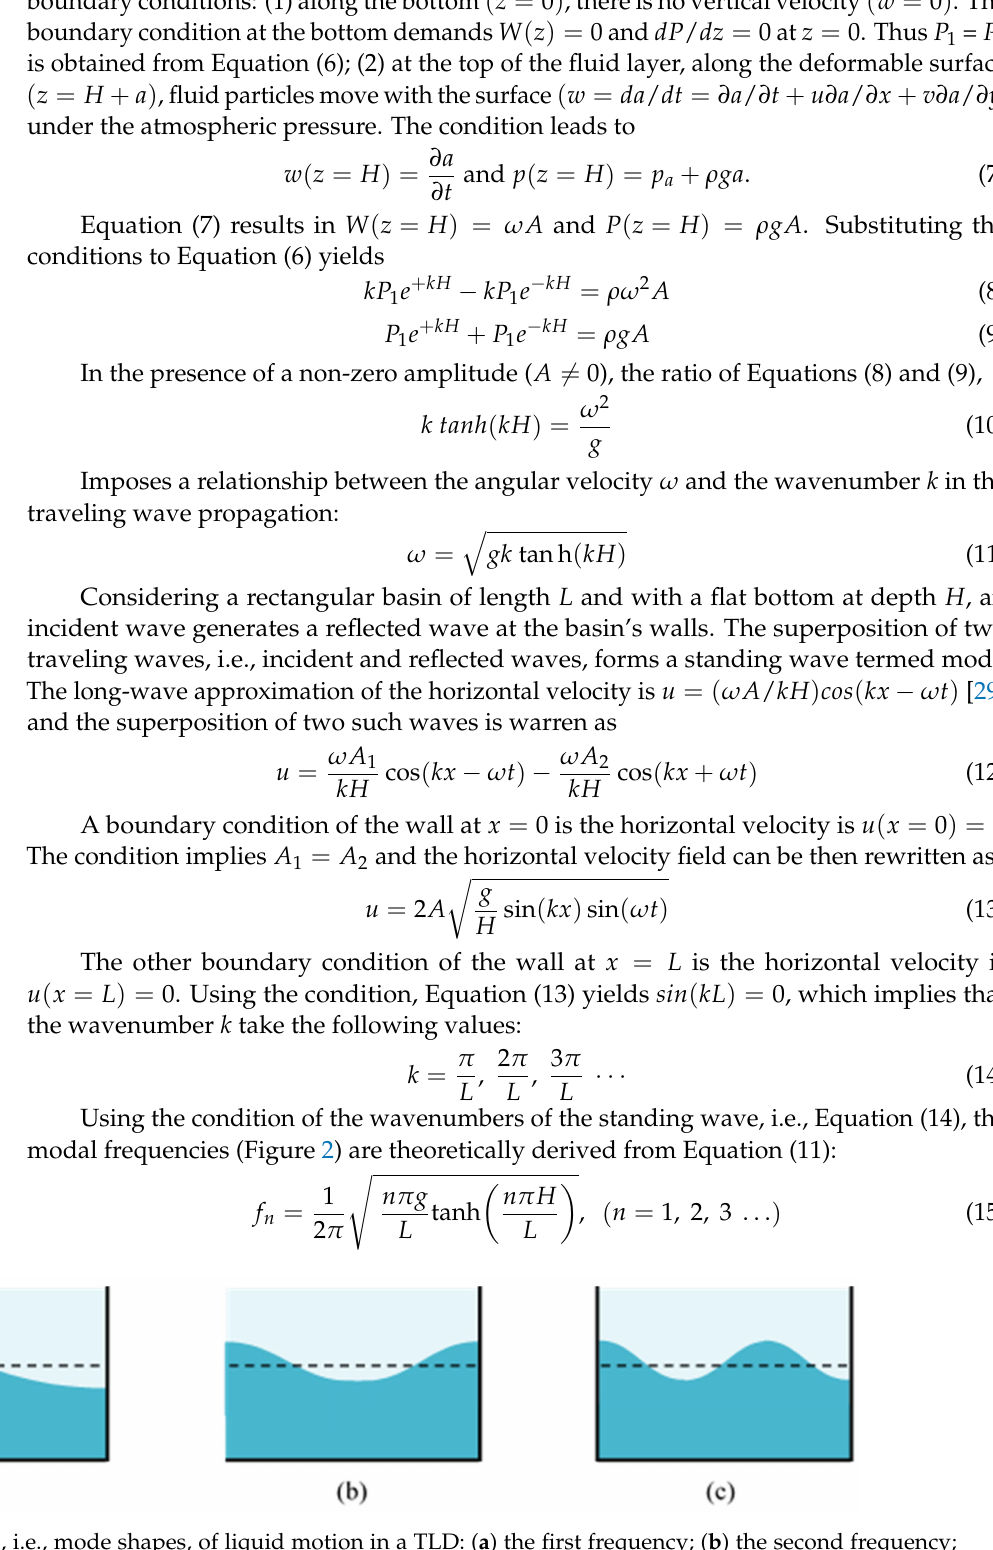
Figure 2. Standing wave, i.e., mode shapes, of liquid motion in a TLD: ( a ) the first frequency; ( b ) the second frequency; ( c ) the third